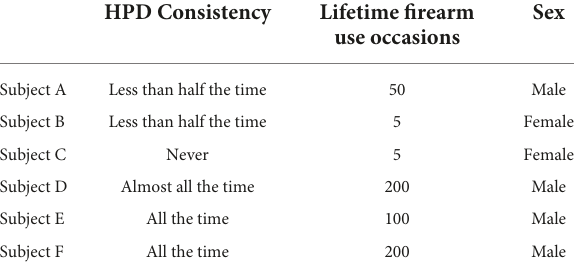
TABLE 1 Unique firearm user subgroup: Inconsistent HPD use and highest occasions of